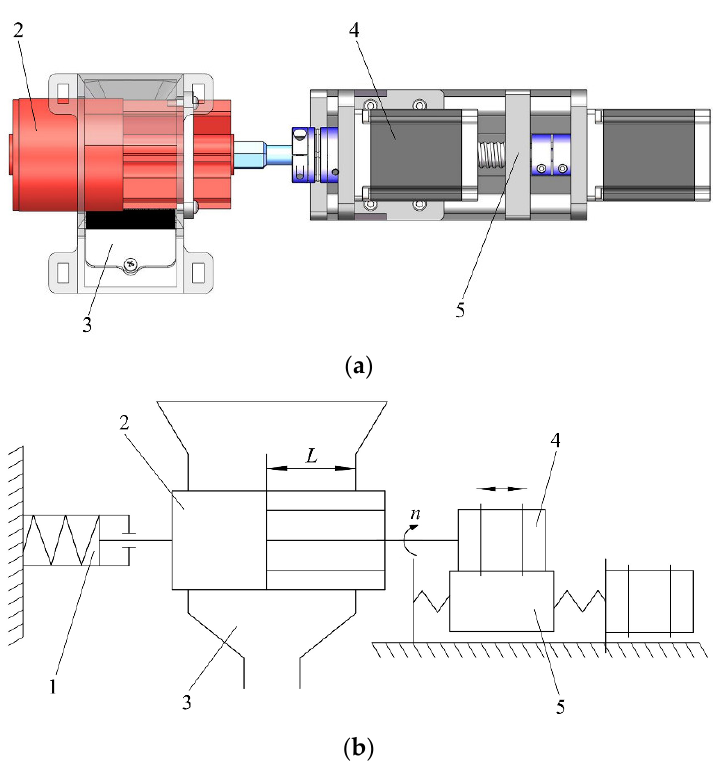
Figure 1. Working principle of bivariate fertilizer discharge device: ( a ) Bivariate outer groove wheel fertilizer discharger; ( b ) Sketch of bivariate control system structure. 1, electronic ruler; 2, outer groove wheel; 3, fertilizer application box; 4, closed-loop stepping motor; 5, ball screw slide.